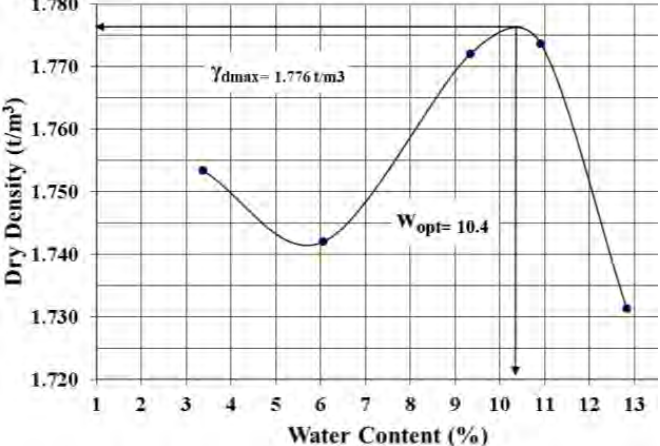
Figure 21. Modified proctor test for specimens from 88.1E km to 89E km at Serapum area